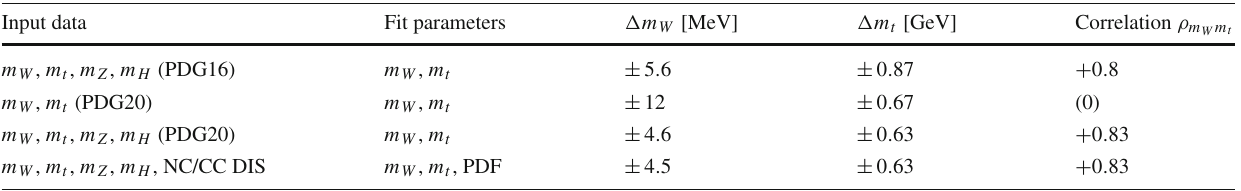
Table 11 Results for expected uncertainties of m W and m t from a simplified global fit, with and without NC/CC DIS data using the LHeC-60b